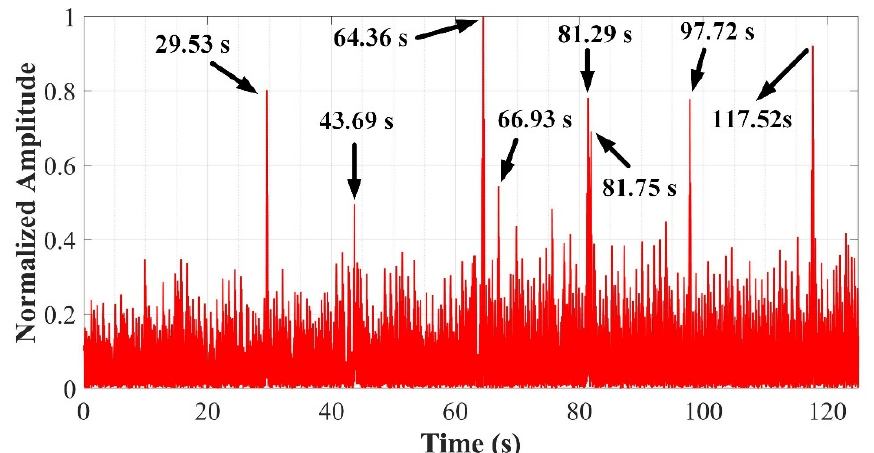
Figure 5. MODWT 5th-level detail decomposition using Haar wavelet of the deteriorated radar-based measurement. Table 1. Accuracy of the radar-based measurements.